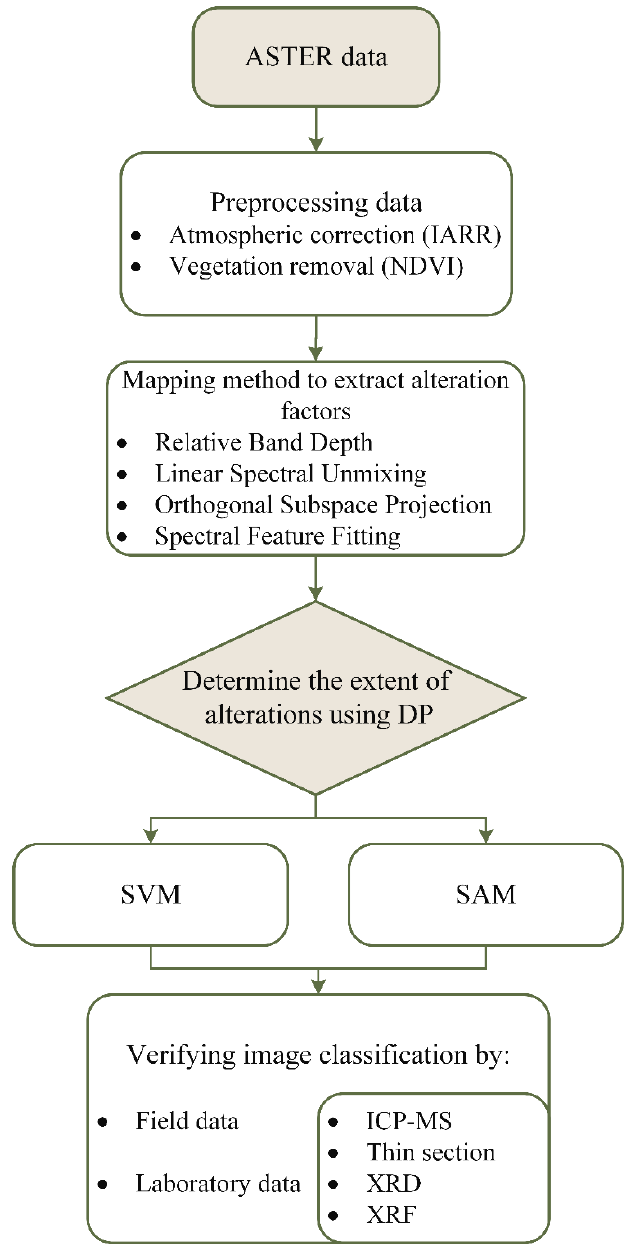
Figure 2. An overview of methodological flowchart used in this study.